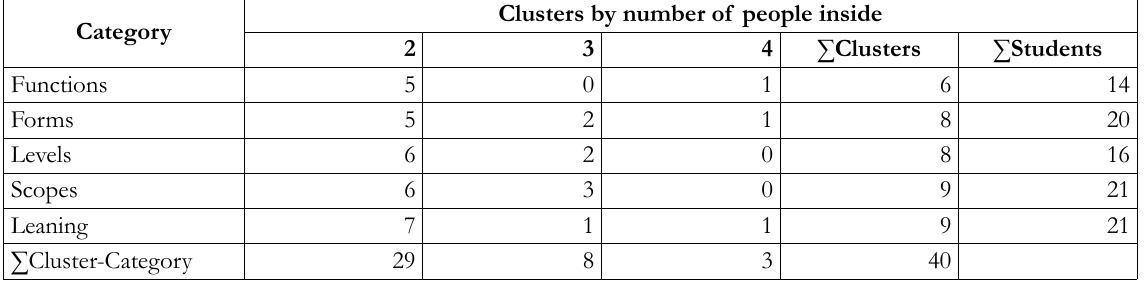
Table 3. Group election by category and its thinking styles cluster size